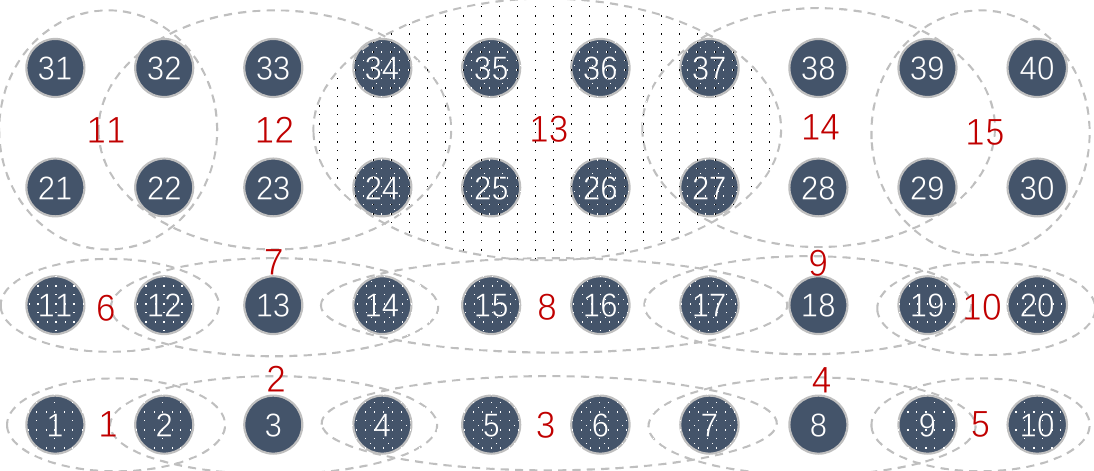
Figure 7. The area code of the force-pad.